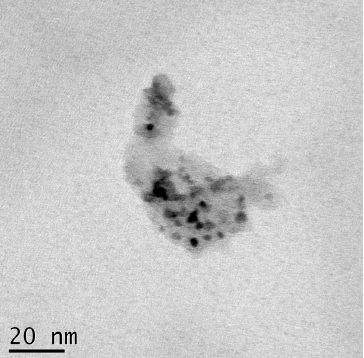
Figure 8. Transmission electron micrograph of spent Re-04RuSi catalyst.